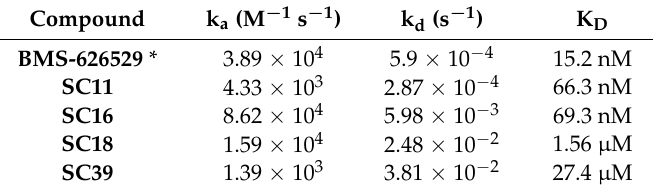
Supplementary Materials.